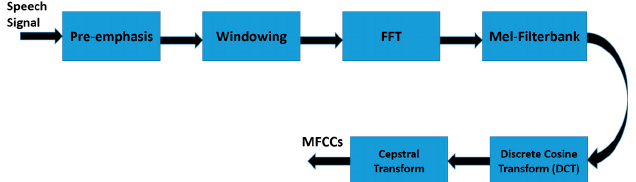
Figure 7. Modular representation of mel-frequency cepstral coefficients (MFCCs) feature extraction process.